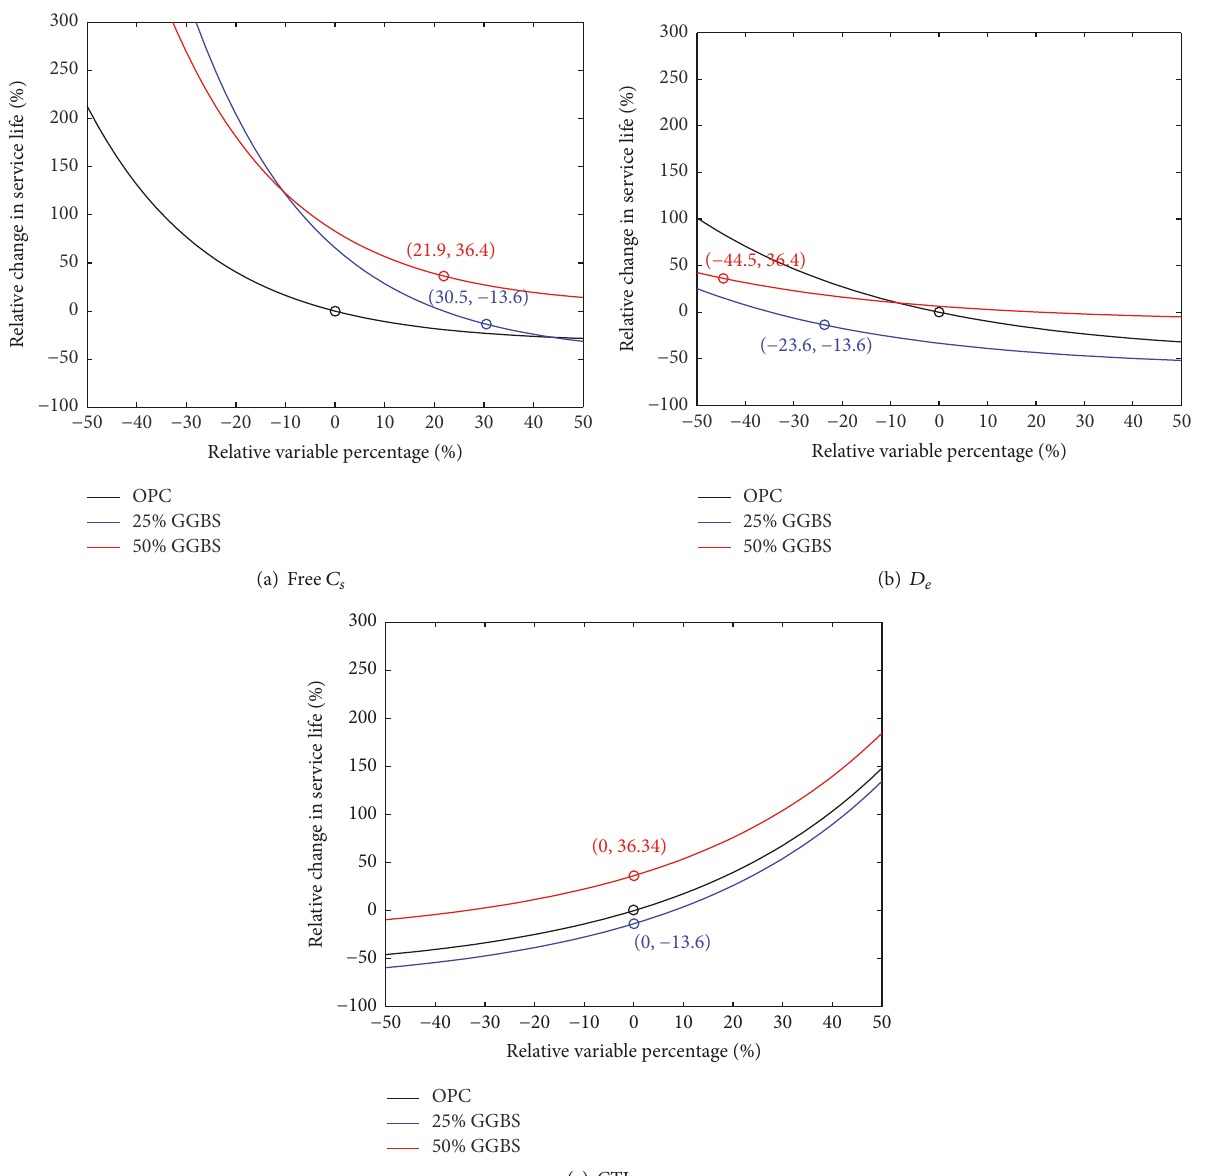
Figure 6: Sensitivity of parameters to service life estimation with percentage change of